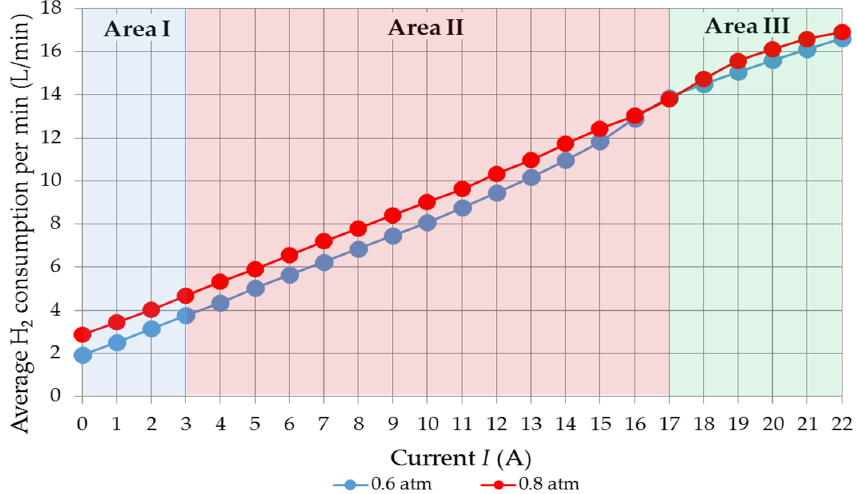
Figure 8. Dependence of the average hydrogen consumption per minute on the load current at p = 0.6 atm (blue line) and 0.8 atm (red line). p = 0.6 atm (blue line) and 0.8 atm (red